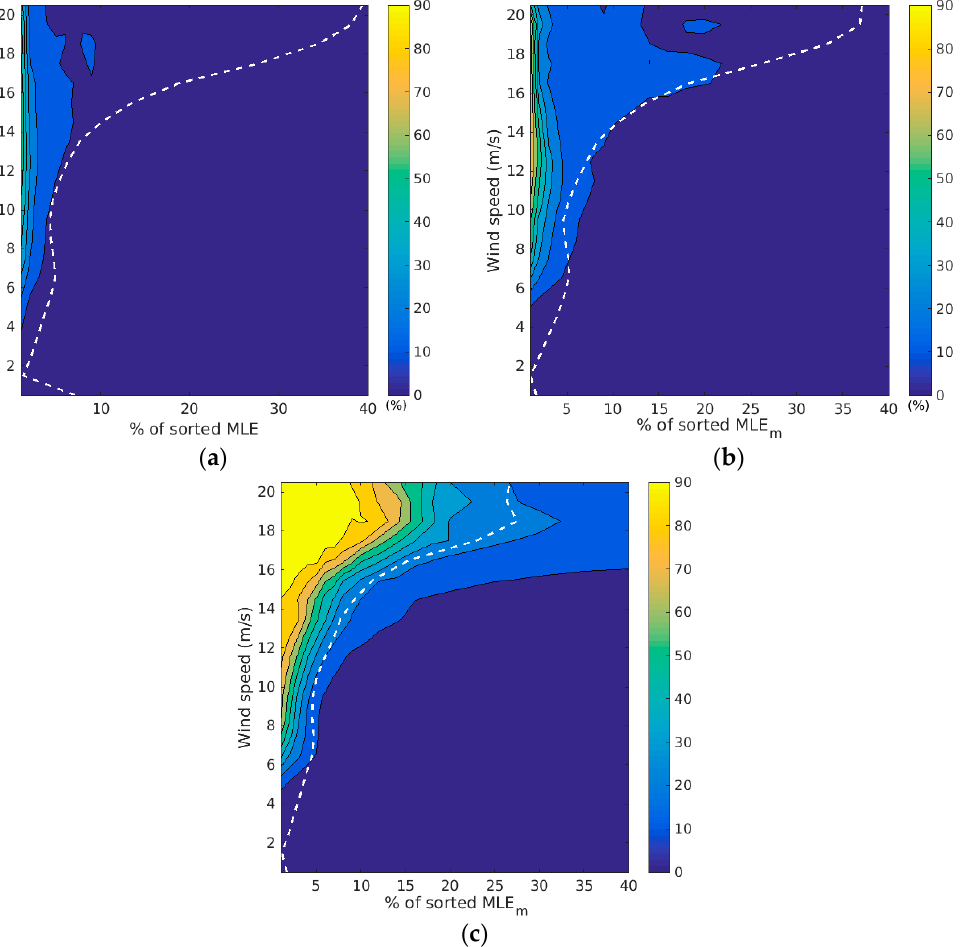
Figure 4. Percentage of rain-contaminated data (GMI RR > 1 mm/h) as a function of HSCAT-B wind speed and the sorted percentiles by ( a ) MLE and ( b ) MLE m . ( c ) Shows the same plot as ( b ), but for RapidScat (figure adapted from [6]).The white dashed curve indicates the rejection ratio of the operational MLE-based QC.